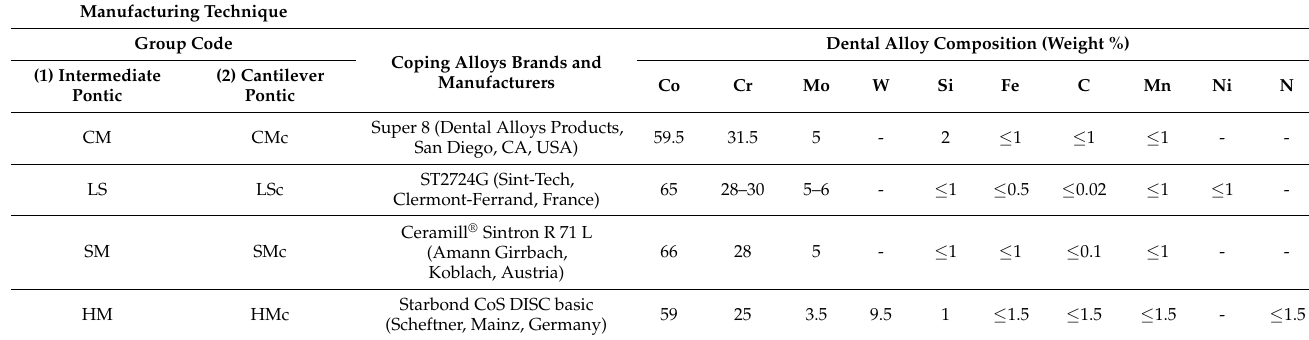
Table 1. Manufacturing technique, brands, manufacturers and chemical composition of the alloys selected for the study (weight